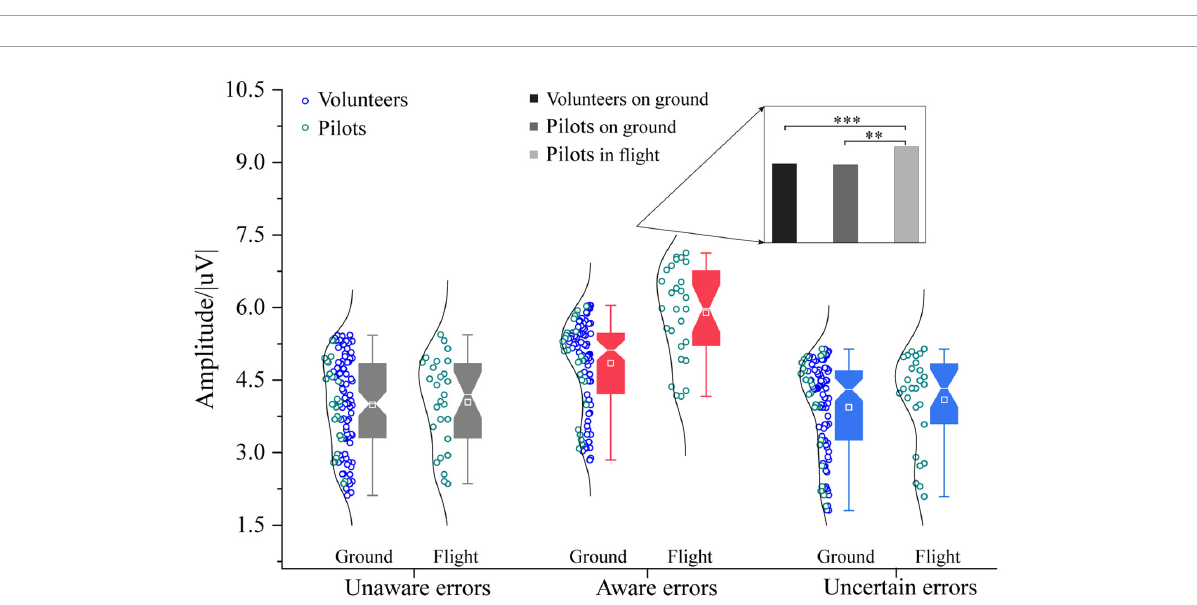
FIGURE7 Differences in Pe (400–500) between pilots and volunteers in multiple error awareness on the ground or in flight environment. The squares in the box plots indicated the mean values, the white horizontal lines indicated the medians, and both ends indicated the maximum and minimum values ( ∗∗ p < 0.001, ∗∗∗ p <